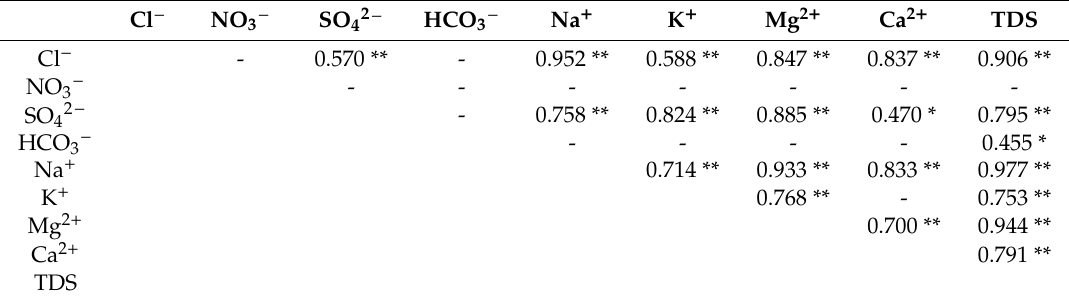
Table 3. Pearson correlation coe ffi cients for hydrochemistry parameters of tectonic lakes.